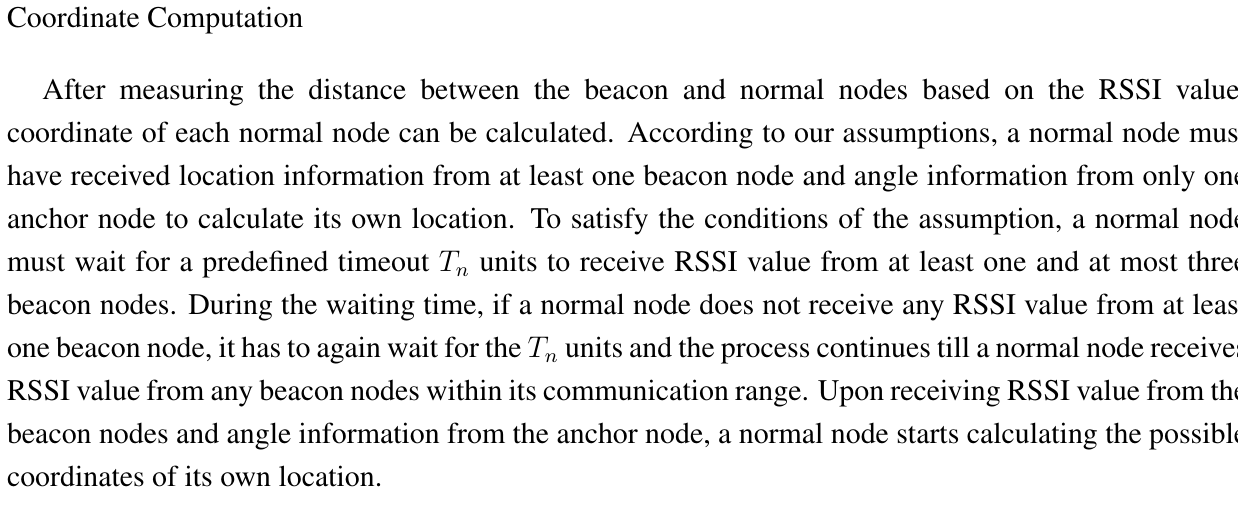
Figure 2. Location computation of a normal node with help of one beacon